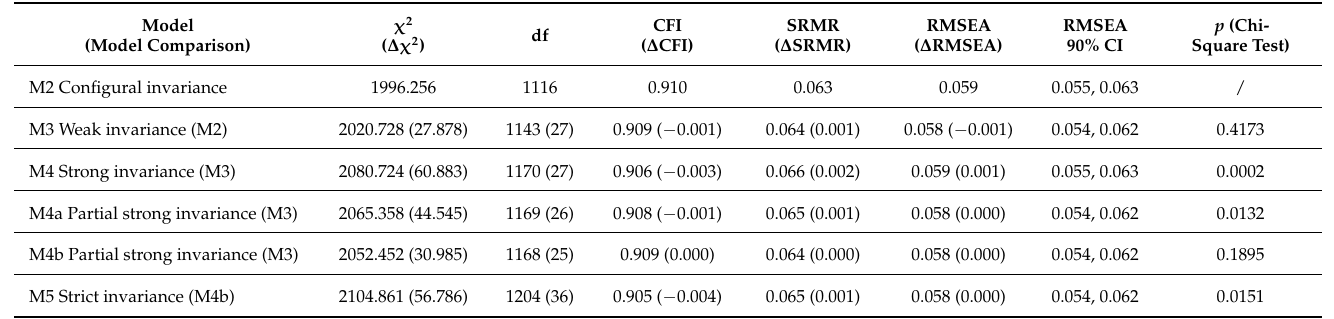
Table 6. Testing measurement invariance between